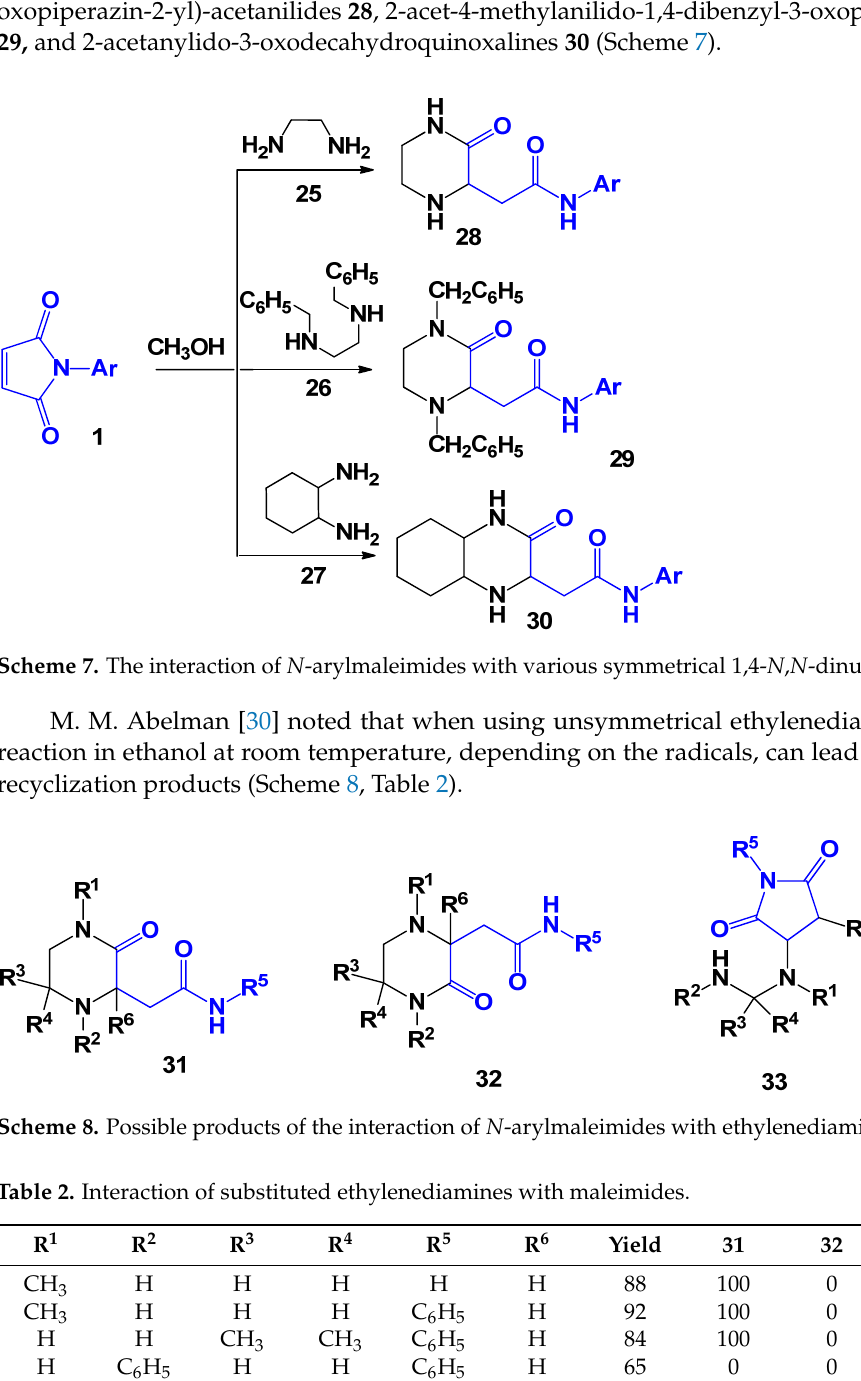
nopyridines. Scheme 6. General scheme and possible mechanism of interaction of N -arylmaleimides with 2-ami-